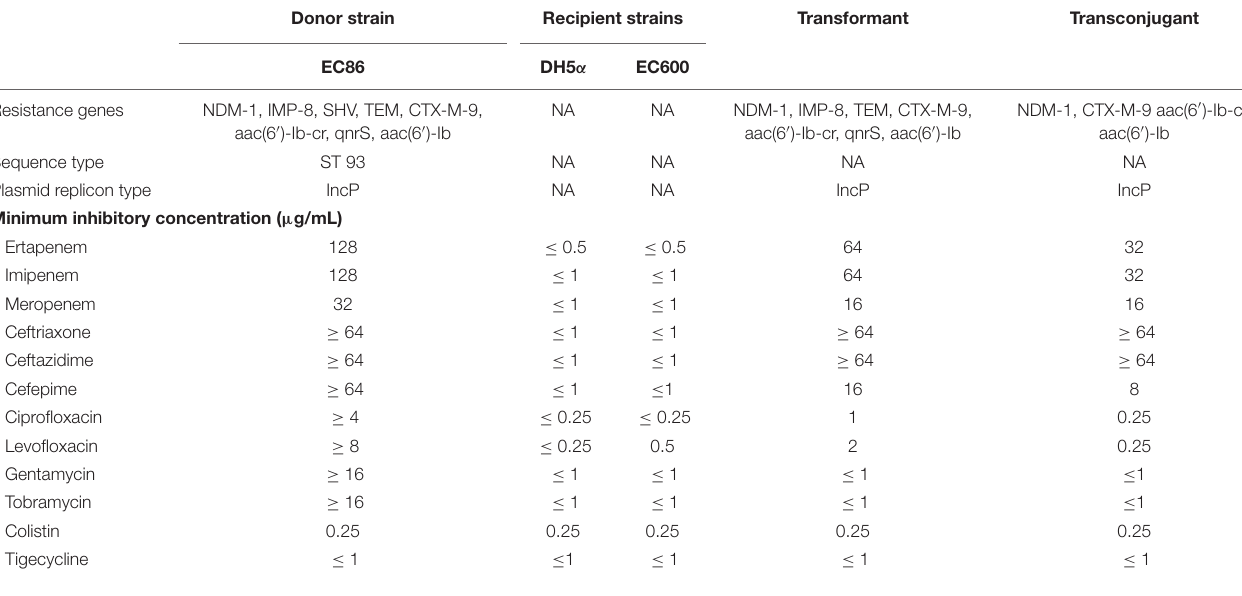
TABLE 3 | Antibiotic resistance genes and susceptibility profiles in donor, E. coli EC600, transconjugant, E.coli DH5 α , and transformant. Donor strain Recipient strains Transformant